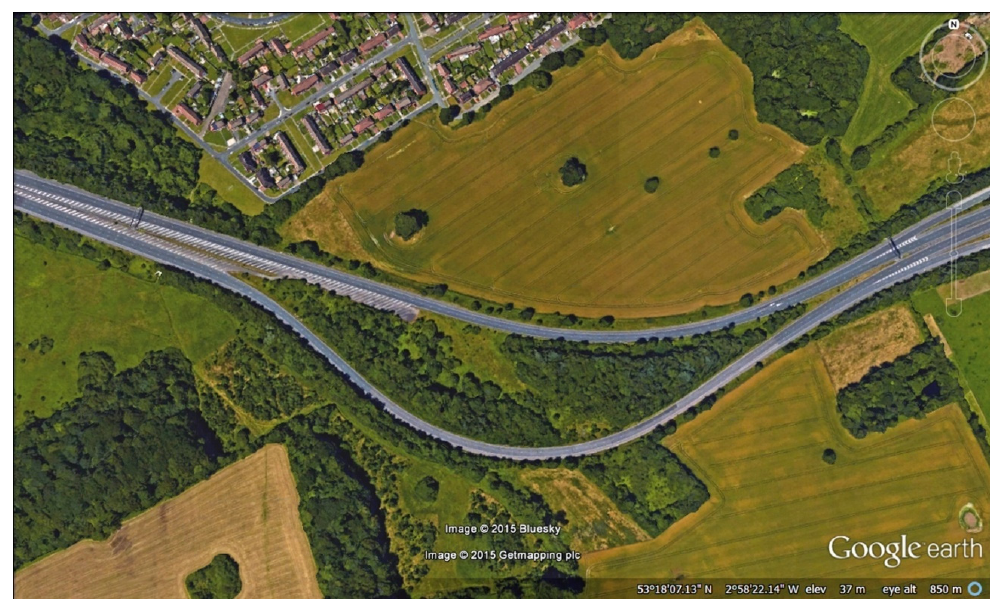
Figure 9. Aerial view of island (Map data: © Google, Bluesky, Getmapping plc [2015]).